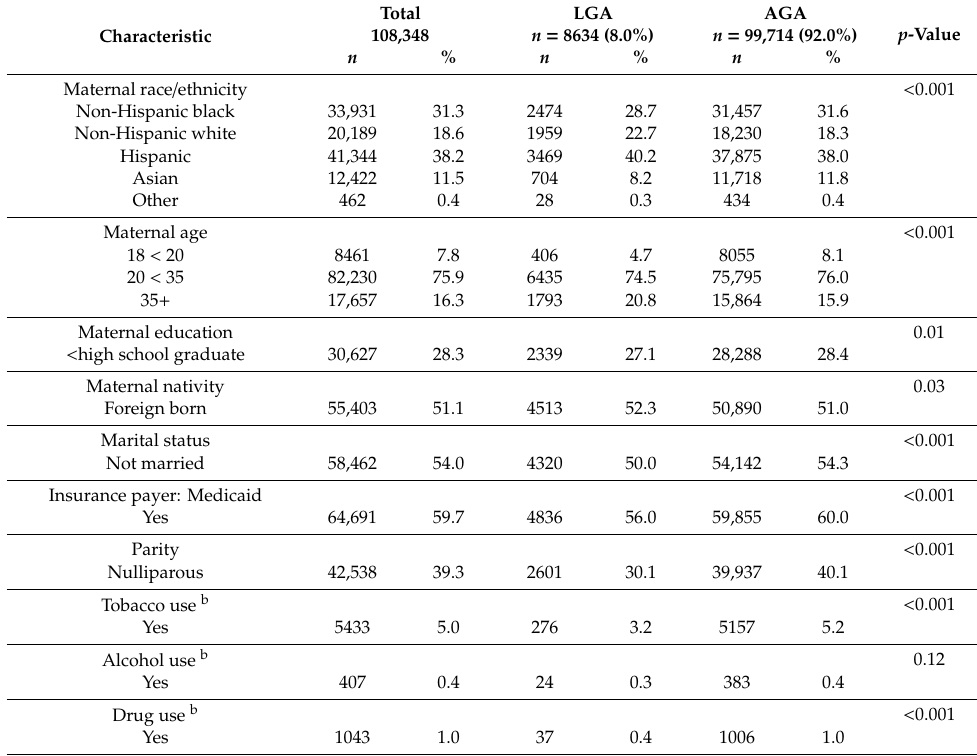
Table 1. Characteristics of cohort by LGA and AGA ( n = 108,348) a